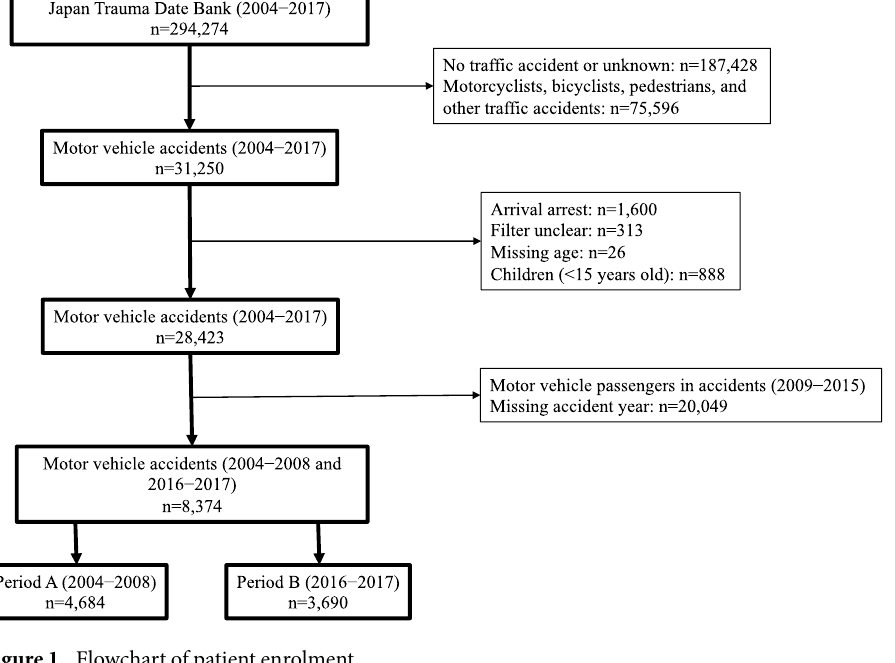
Figure 1. Flowchart of patient